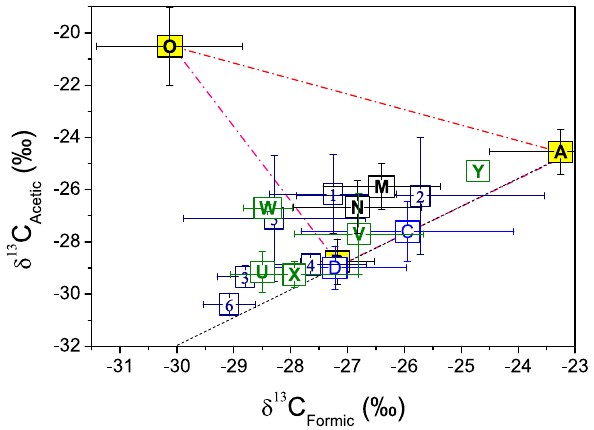
Figure. 1. Mean δ 13 C of formic and acetic acid in the tropospheric environments and the sources of fossil fuel combustion, marine release and primary biogenic emission. The yellow-colored squares indicate the sources. A: fossil fuel combustion; B (covered mostly by D): primary biogenic emission; O: marine emission as averaged from the δ 13 C of precipitation at Westwood, Los Angeles, California, USA 48 ; C: air in the street valley of downtown Guiyang; D: air over the urban forest in Guiyang; M and N: urban air during March and August– September, respectively, in Zurich, Switzerland 51 ; U: urban air at Oslo, Norway; V: rural air at Tommerup, Denmark; W and X: air at semi-remote Ulfborg and Anholt, Denmark, respectively; Y: precipitation at semi- remote Anholt, Denmark 45 ; digits 1–6: precipitation events in Guiyang as specified in Table 1. Error bars are 2σ standard deviation. The dash-dot lines link the source, the dash line indicates δ 13 C Formic /δ 13 C Acetic of 0.94.